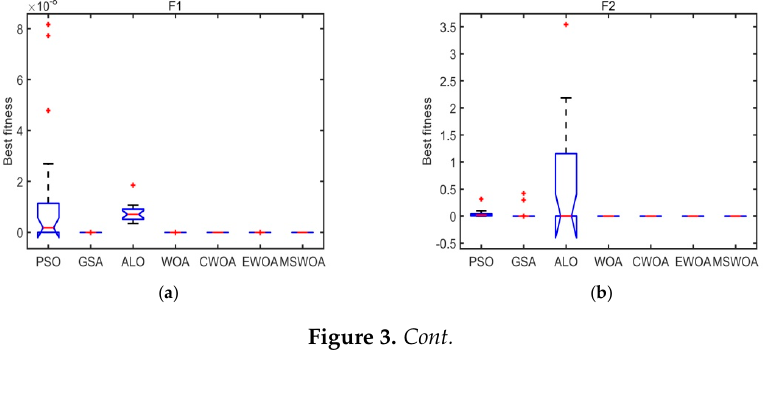
Table 8. The Wilcoxon signed-rank multiple-problem test for statistically significance level at alfa = 0.05. Comparison